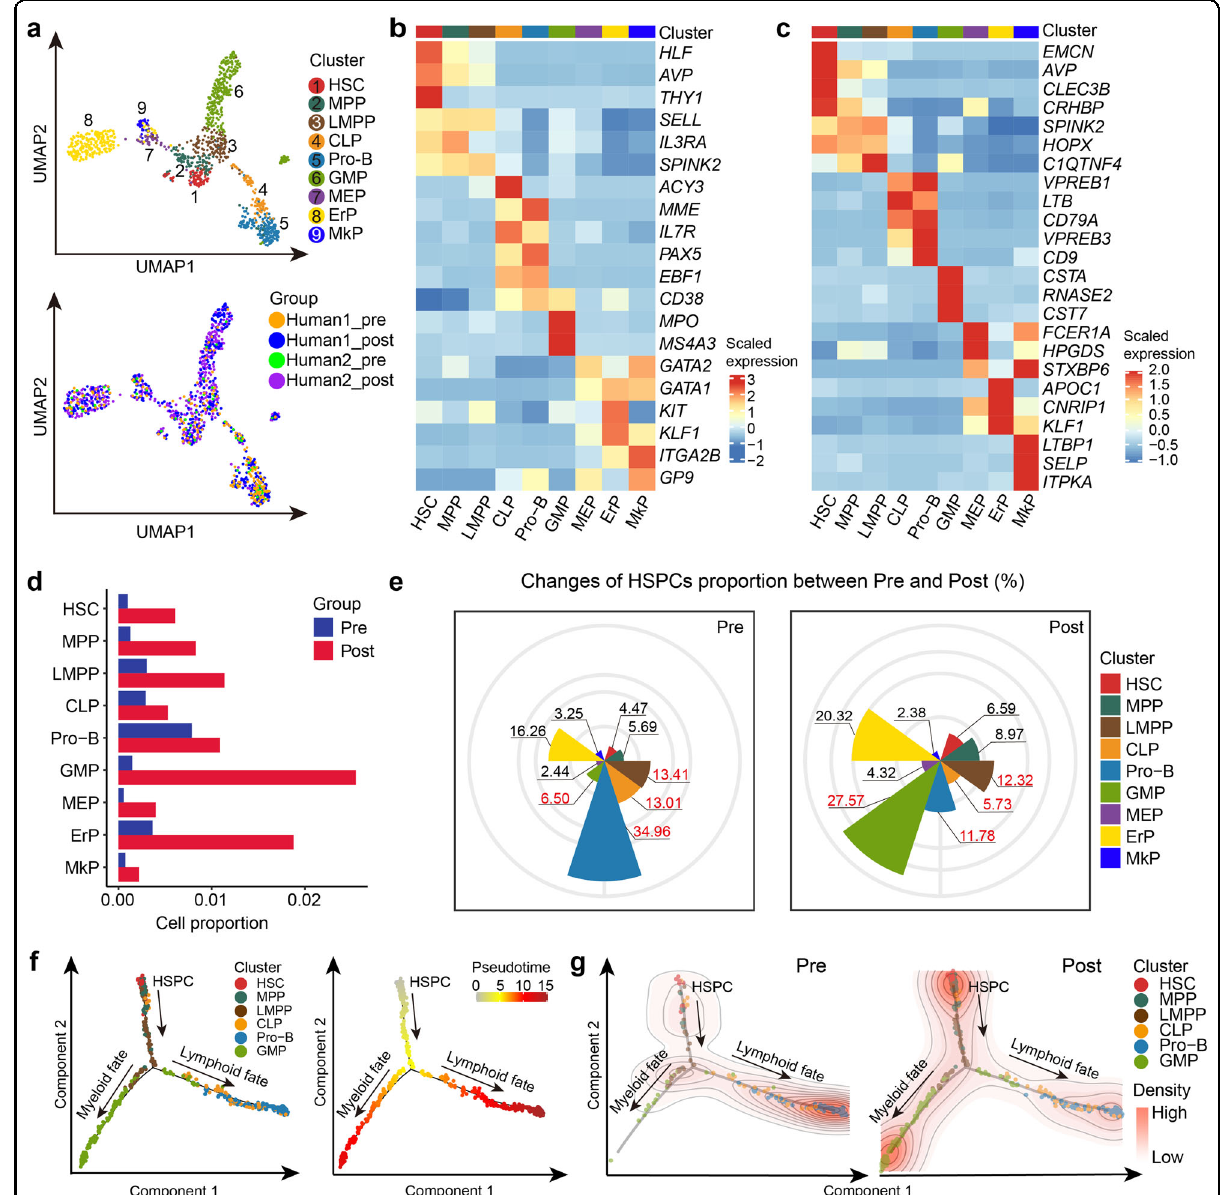
Fig. 2 The effect of G-CSF on hematopoietic differentiation in human BM. a UMAP visualization of subclusters in HSPCs. Each dot represents a single cell; colors indicate clusters (top) and sources of samples (bottom). HSC hematopoietic stem cell; MPP multipotential progenitor; LMPP lymphoid-primed multipotent progenitor; CLP common lymphocyte progenitor; Pro-B progenitor B cell; GMP granulocyte-monocyte progenitor; MEP megakaryocyte/erythroid progenitor; ErP erythroid progenitor; MkP megakaryocyte progenitor. b Heatmap displaying scaled expression of canonical cell type-associated genes for clusters in a . Color scale corresponds to z-scored, log-transformed mean gene-expression counts for each cell state. c Heatmap showing scaled expression of top 3 DEGs for clusters in a . Color scale corresponds to z-scored, log-transformed mean gene- expression counts for each cell state. Detailed DEGs can be found in Supplementary Table S2. d Bar plot showing the changes in the percentage of subclusters of HSPCs upon G-CSF treatment. e Cell proportion of each subcluster within HSPCs derived from BM grafts before (left) and after (right) G-CSF administration. f Monocle prediction of HSPC developmental trajectory with cluster information (left) and pseudotime (right) mapped. g Density plots displaying the distribution of different hematopoietic progenitor cells in trajectories before (left) and after (right) G-CSF administration. These plots were based on the 2D kernel density estimation. The density of lines and intensity of colors are proportional to cell density in each